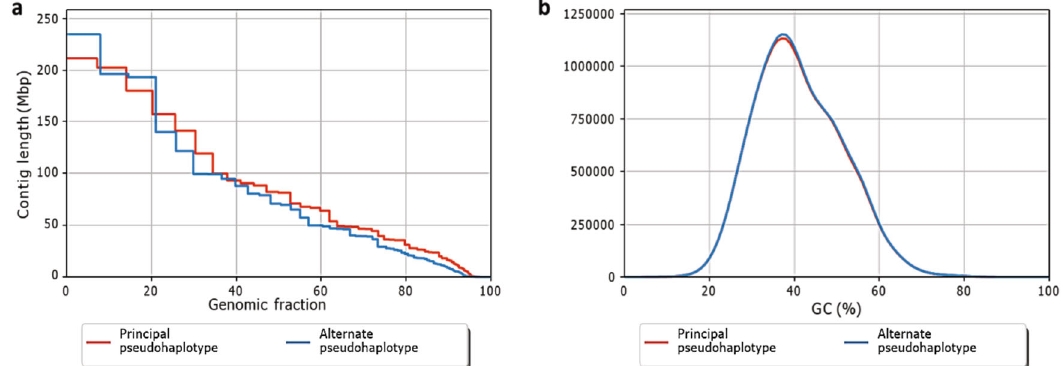
Fig. 2 Quality control of the Vero genome de novo assembly. a Nx plot: Length ordered contigs. b Distribution of GC content in the